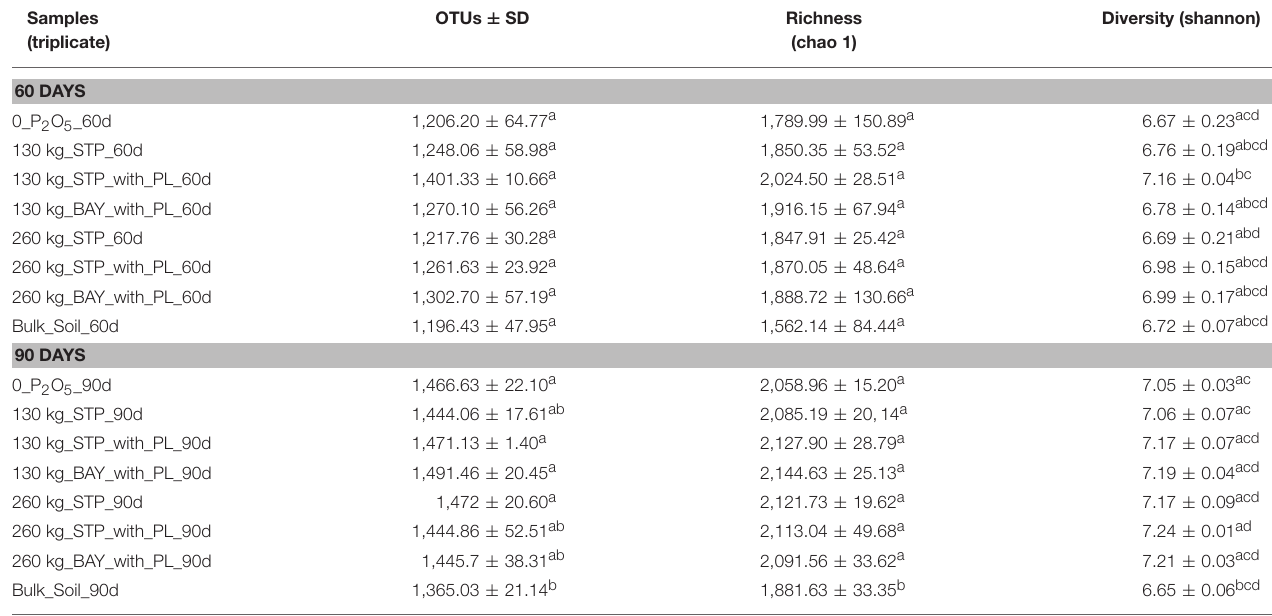
TABLE 1 | Estimated OTUs, as well as richness and diversity indices based on the OTU generated matrices. Samples